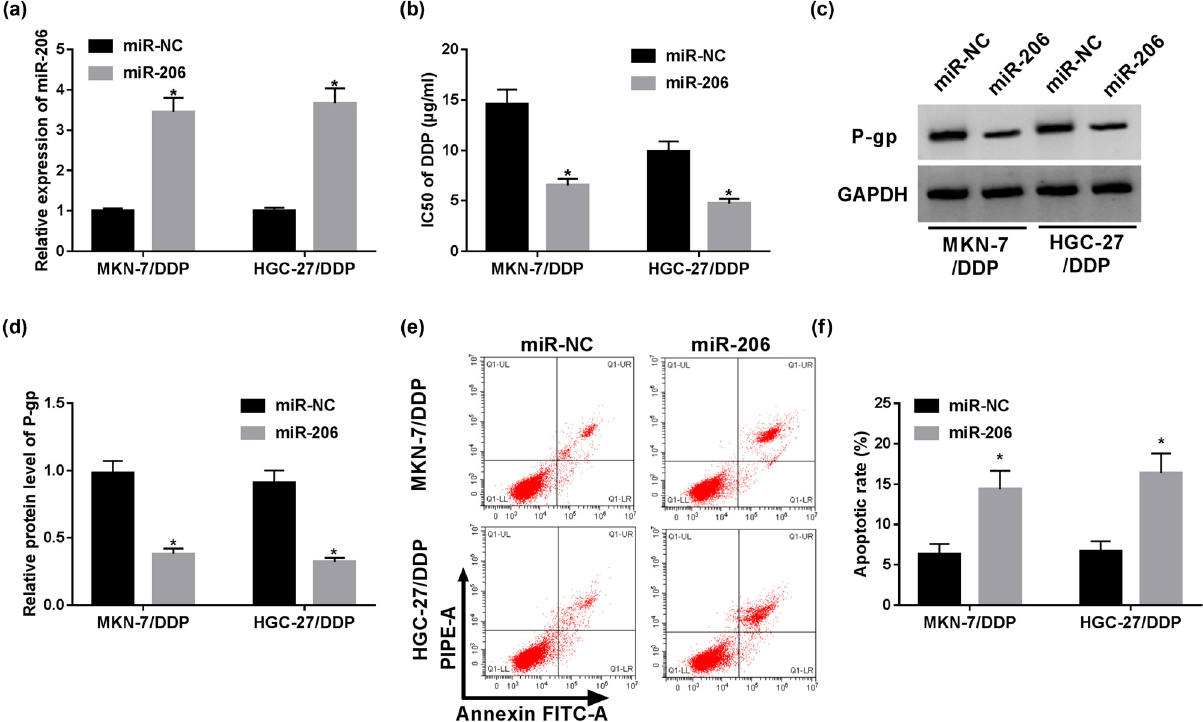
Figure 3: Overexpression of miR - 206 suppresses cisplatin resistance of resistant GC cells. The expression of miR - 206 ( a ) , IC 50 of cisplatin ( b ) , P - gp protein level ( c and d ) and apoptosis ( e and f ) were detected in MKN - 7/DDP and HGC - 27/DDP cells with transfection of miR - 206 mimic or miR - NC via RT - qPCR, MTT, Western blot and fl ow cytometry, respectively. * P <